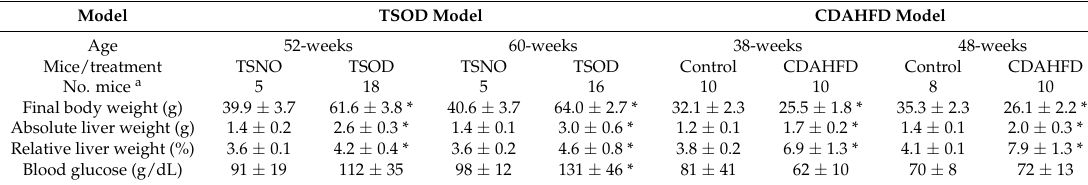
Table 1. Final body and organ weights in two mouse models.